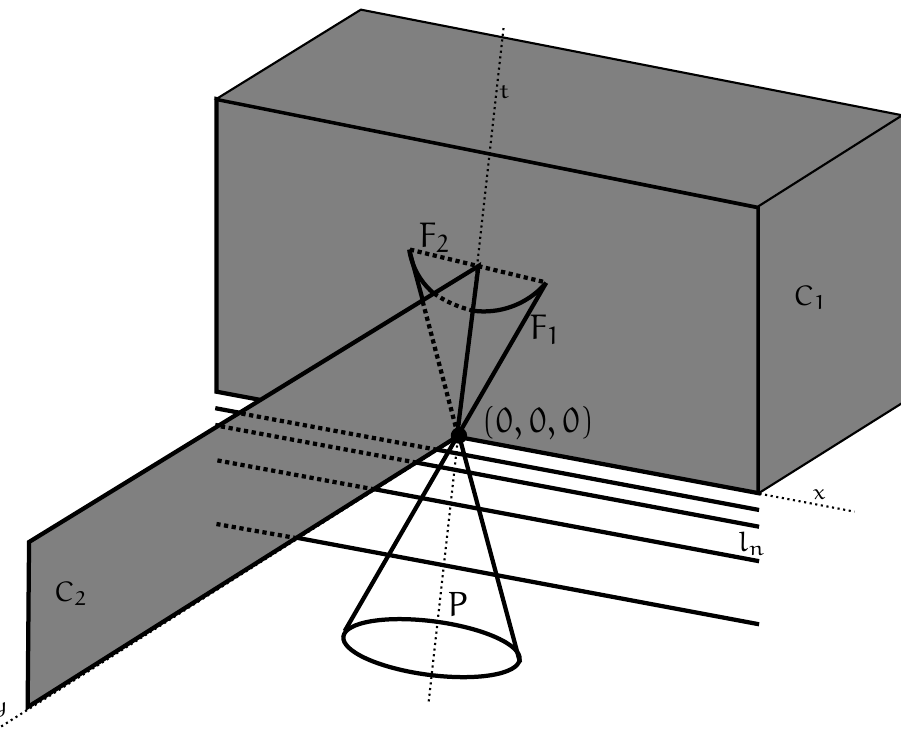
Figure 6 . The space M is an open set of the three-dimensional Minkowski spacetime with the sets C 1 , C 2 and the sequence of lines f l n g removed. The point ( 0; 0; 0 ) is represented on the c-boundary of M as two points ( P; F 1 ) and ( P; F 2 ) . As happen in (cid:12)gure 5, the lift of P to a (cid:12)xed (cid:12)bre of the universal cover of M give us two terminal sets P and P 0 . In particular, and recalling again that " P = ; , we deduce that the pairs ( P 0 ; F 1 ) ; ( P 0 ; F 2 ) and ( P; ; ) belong to @V , the c-boundary of the universal cover of M